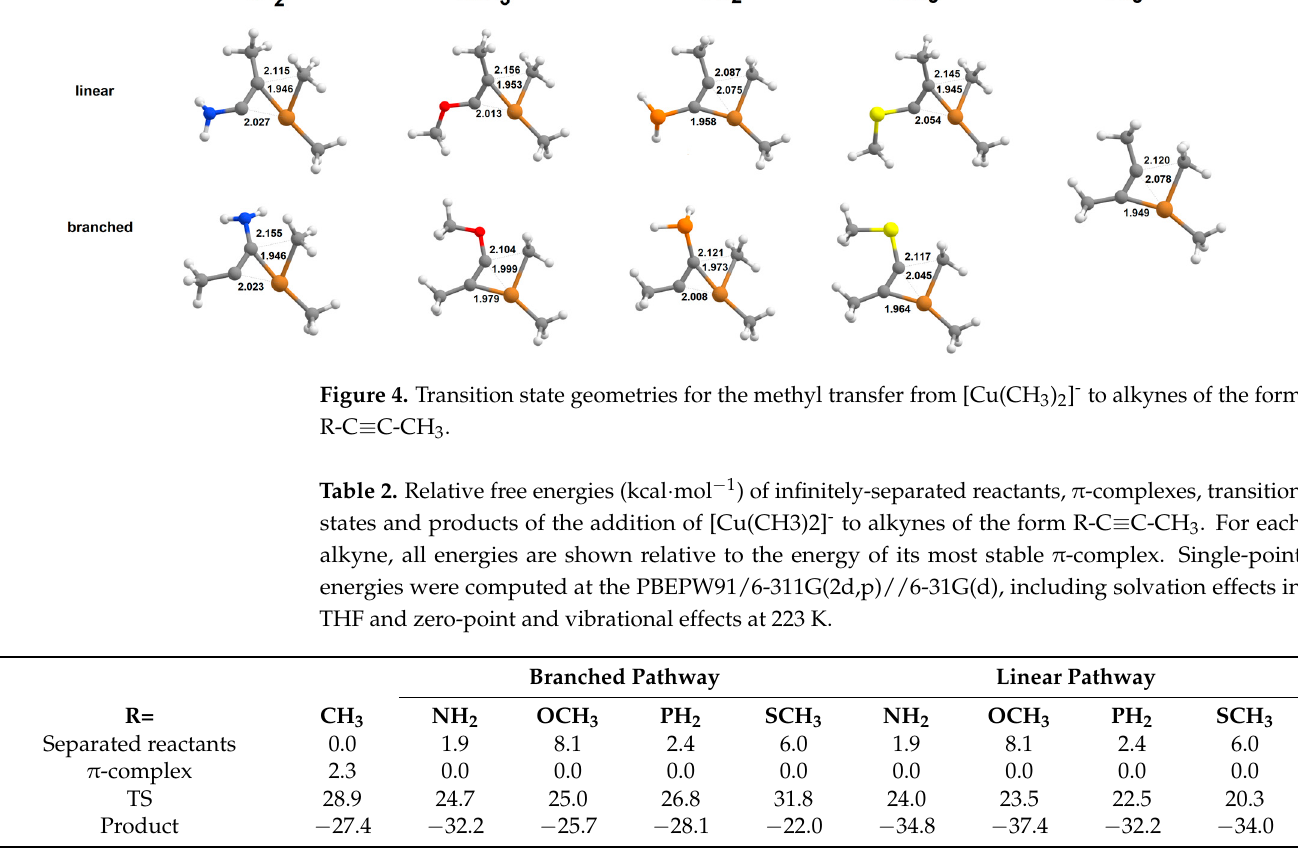
Table 3. Relative Gibbs free energies (kcal·mol − 1) of π -complexes, transition states, and products of the addition of Cu(CH3)2·Li to small non-functionalized alkynes. For each alkyne, all energies are shown relative to the energy of infinitely separated reactants. Single-point energies were computed at the PBEPW91/6-311G(2d,p)//6-31G(d), including solvation effects in THF and zero-point and vibrational effects at 223 K.